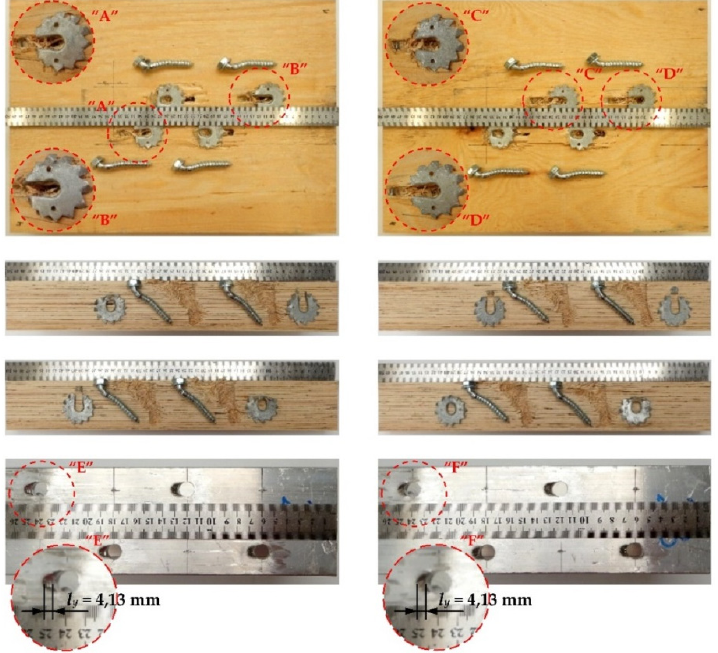
Figure 13. The mode of failure of the aluminium-timber connection with the 12 mm screws and the reinforcing toothed plates (C2-50/M12G, Bulldog).